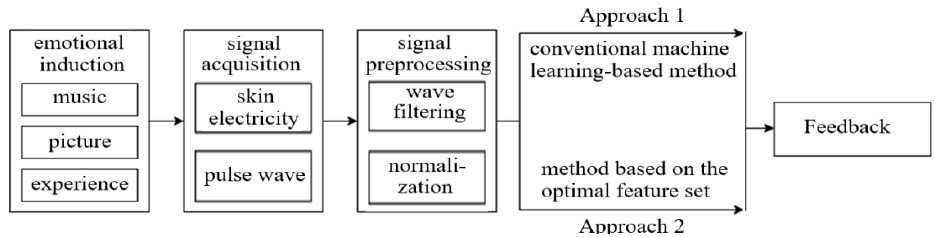
Figure 5. Two approaches of emotion